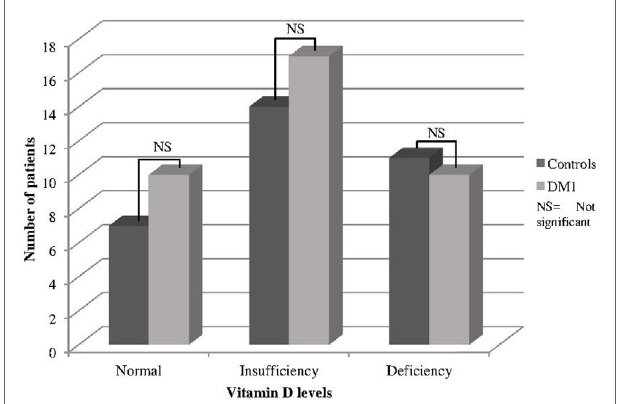
FigUre 2 | correlation between vitamin D levels and albuminuria in patients with T1DM